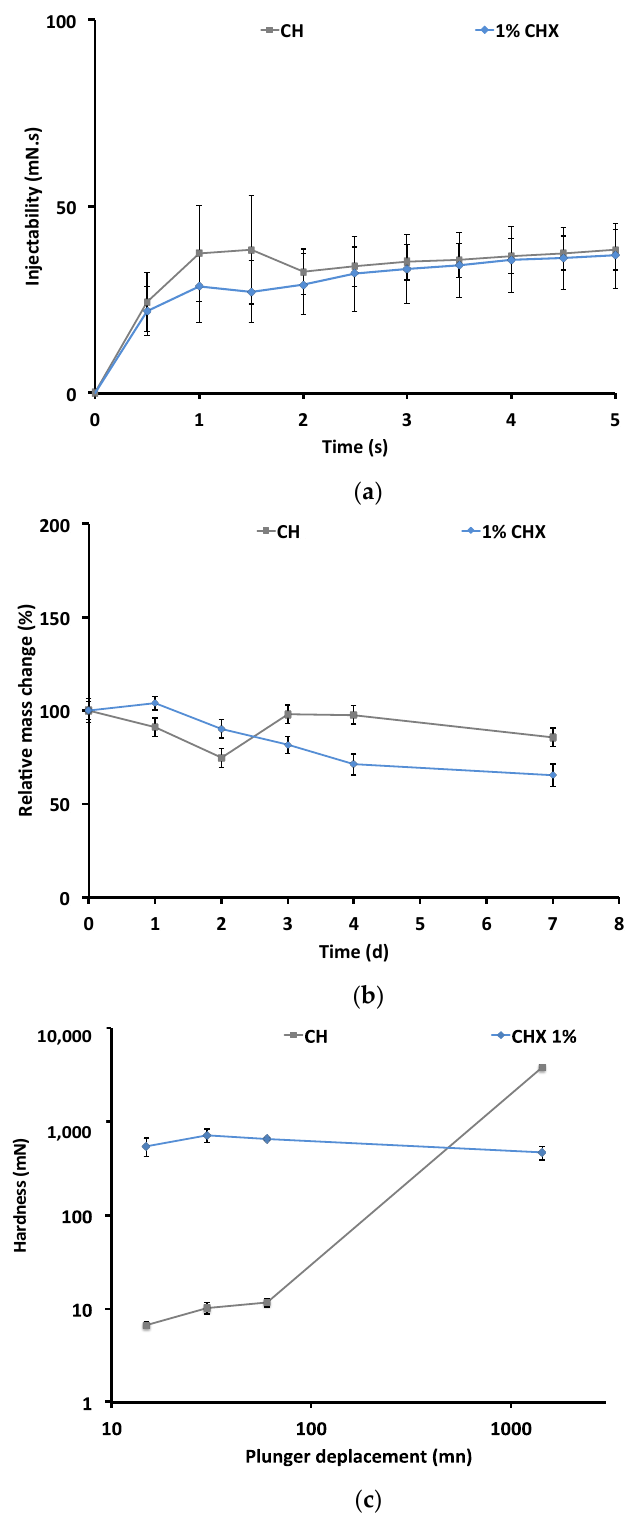
Figure 3. Physical properties of the chlorhexidine-free calcium hydroxide paste (CH) and the calcium hydroxide paste containing 1% chlorhexidine (CHX) (10 × 10 3 mg/L); ( a ) injectability; ( b ) effect of CHX on mass change; ( c ) setting